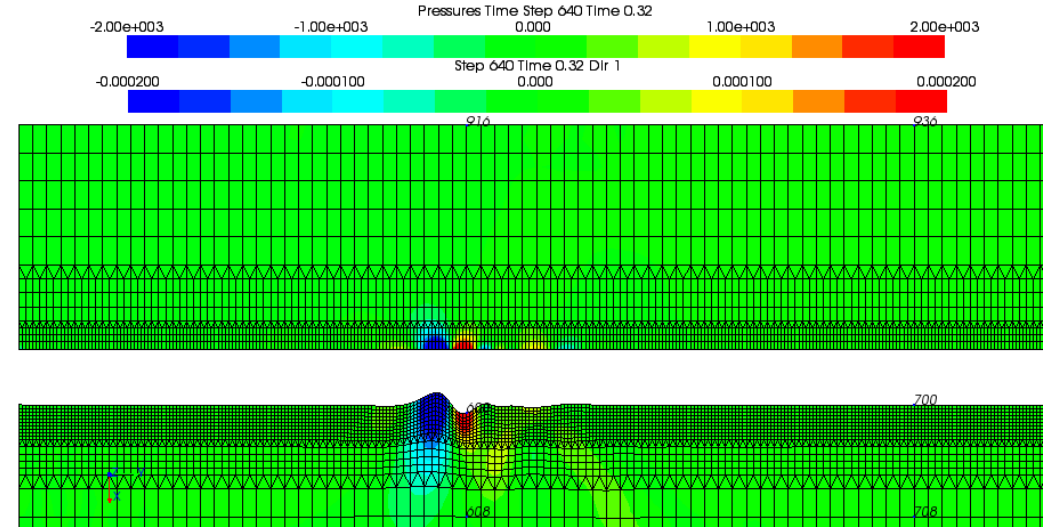
Figure 3. A wavelet is shown at 0.32 s after the impact, 30 m from the source at the symmetry axis, on the left side. The white gap between the 16 m deep water and the underlying sediment is for clarity, showing its exaggerated deformation. Six nodes are shown, #600 at 32 m radius on the seabed, #916 m on the sea surface above, and #608 at 8 m below, plus #700, #708 and #936 at 64 m radius. The water pressures are indicated by the upper bar and vertical solid displacements by the lower bar.